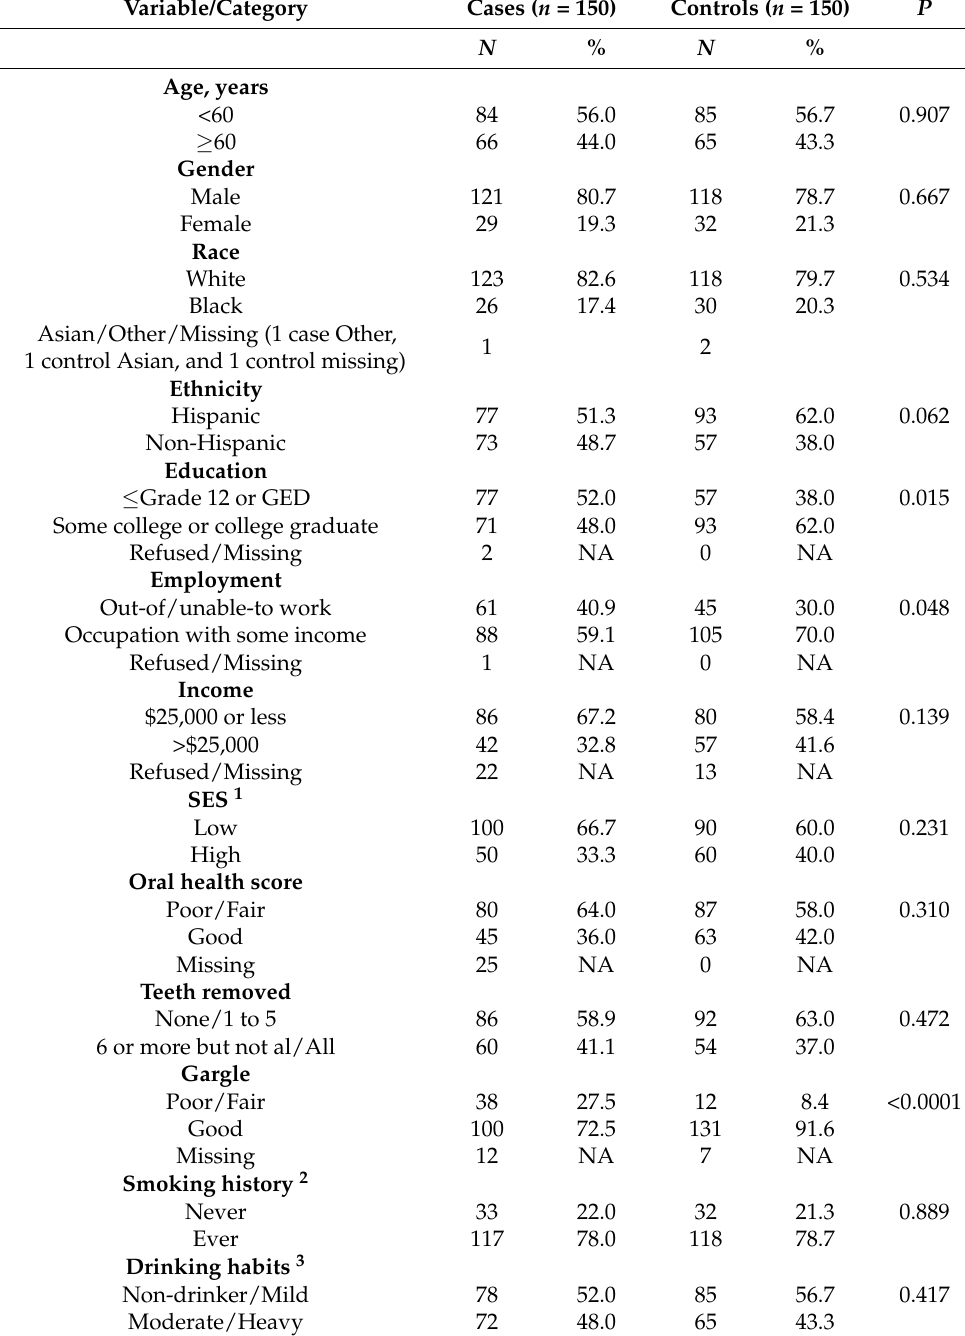
Table 1. Characteristics of cases and